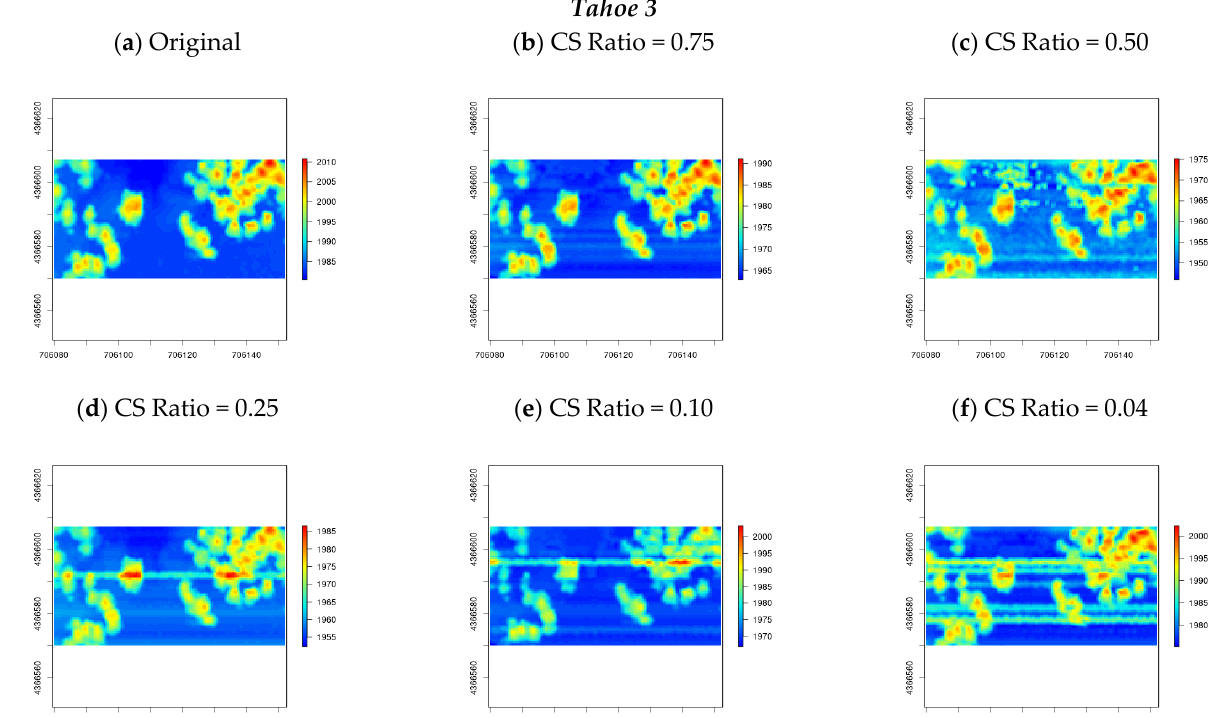
Figure 11. Visualization of the generated Canopy Height Model (CHM) of the original and recon- structed 3D LiDAR point clouds using the proposed ADCoSNet for the Tahoe 1, Tahoe 2, and Tahoe 3 test sites. ( a ) Original; ( b ) CS Ratio = 0.75; ( c ) CS Ratio = 0.50; ( d ) CS Ratio = 0.25; (e ) CS Ratio = 0.10; ( f ) CS Ratio = 0.04.